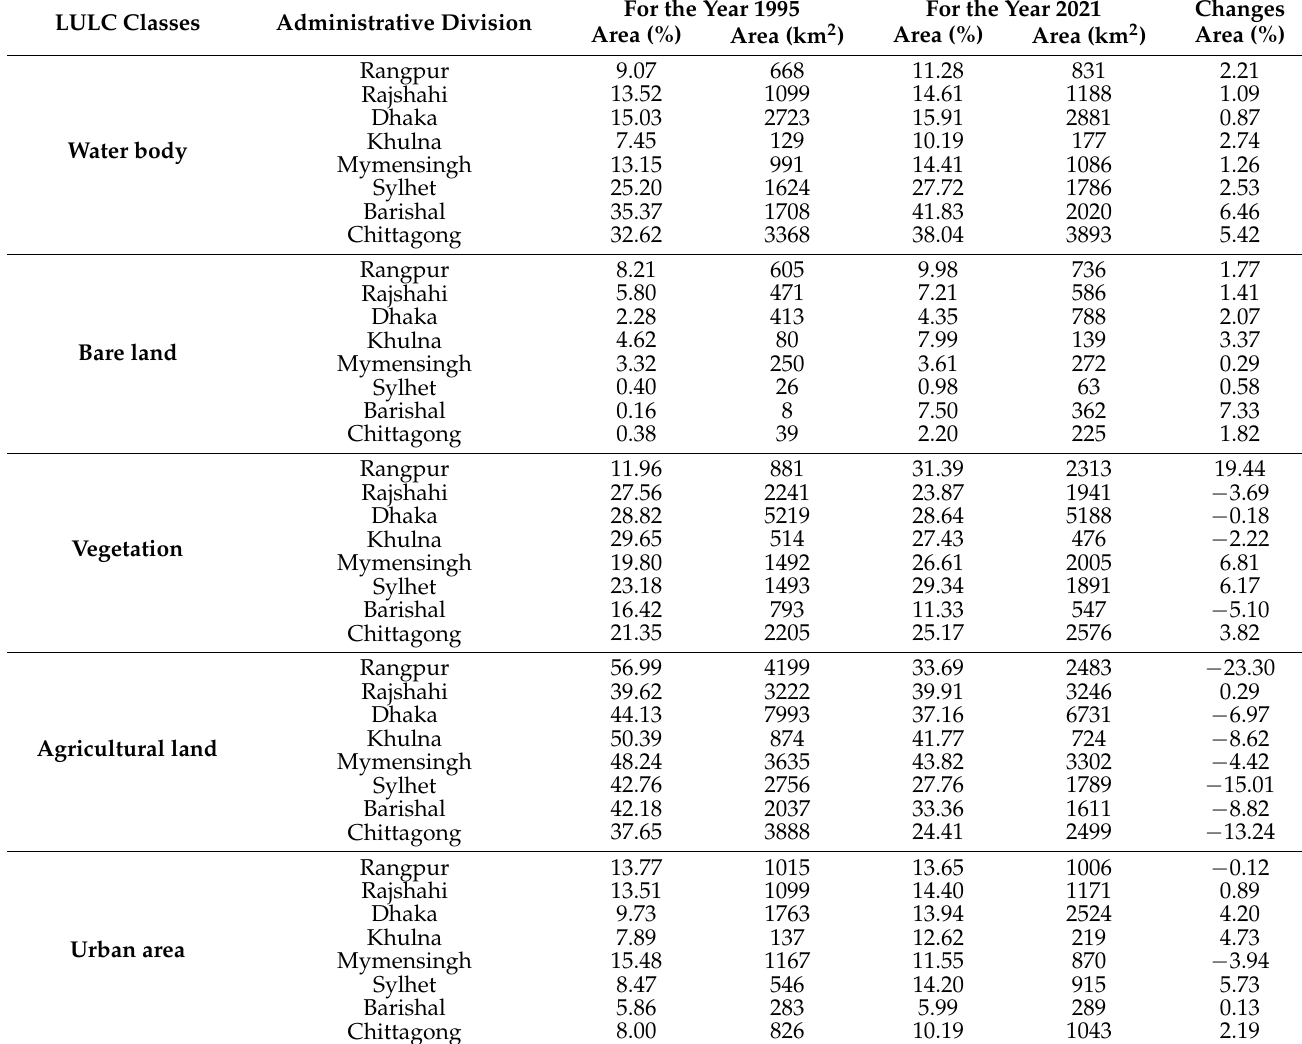
Table 3. LULC changes from 1995 to 2021 in eight administrative divisions in